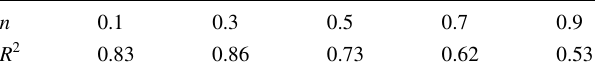
Table 6 Linear fitting with different n in countercurrent case ( R the goodness of